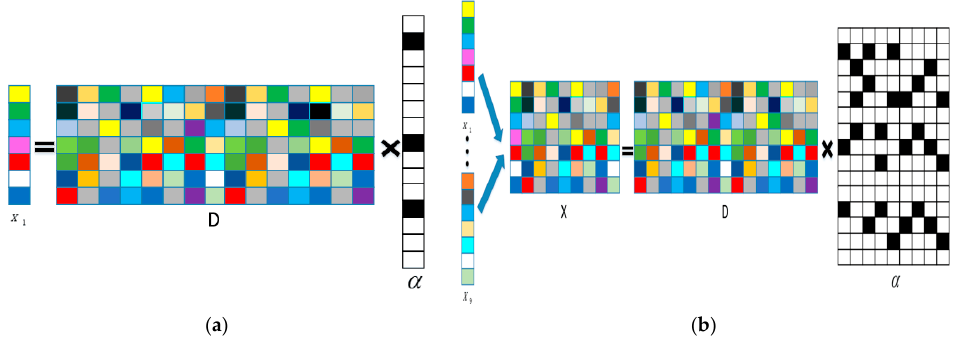
Figure 2. ( a ) Sparse model; ( b ) joint sparse model.